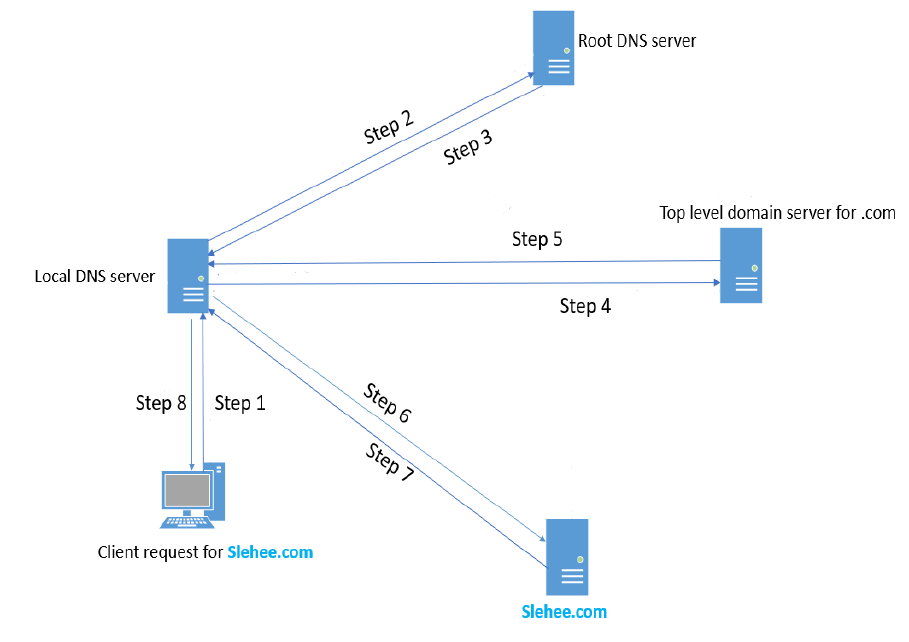
Figure 2. Resolution path of the DNS hierarchical